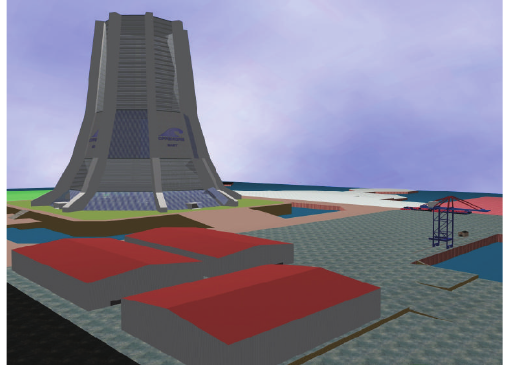
Figure 17: O ff shore—a basic MMOG.